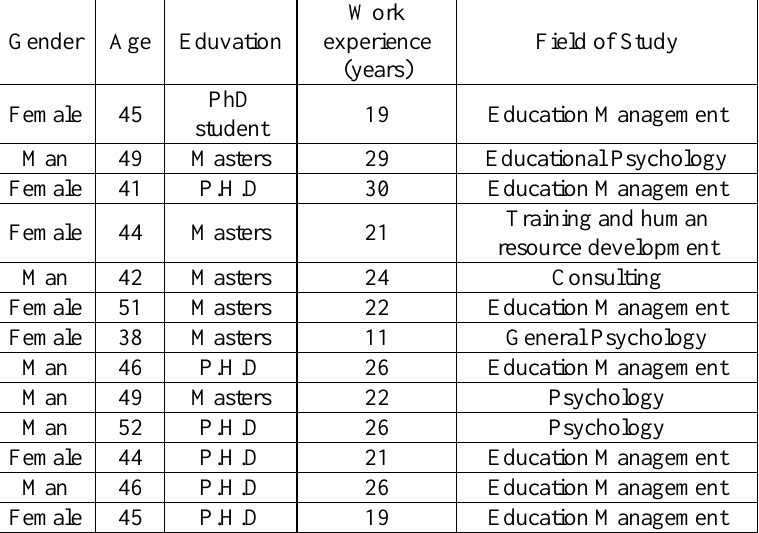
Table 1: Sample demographic